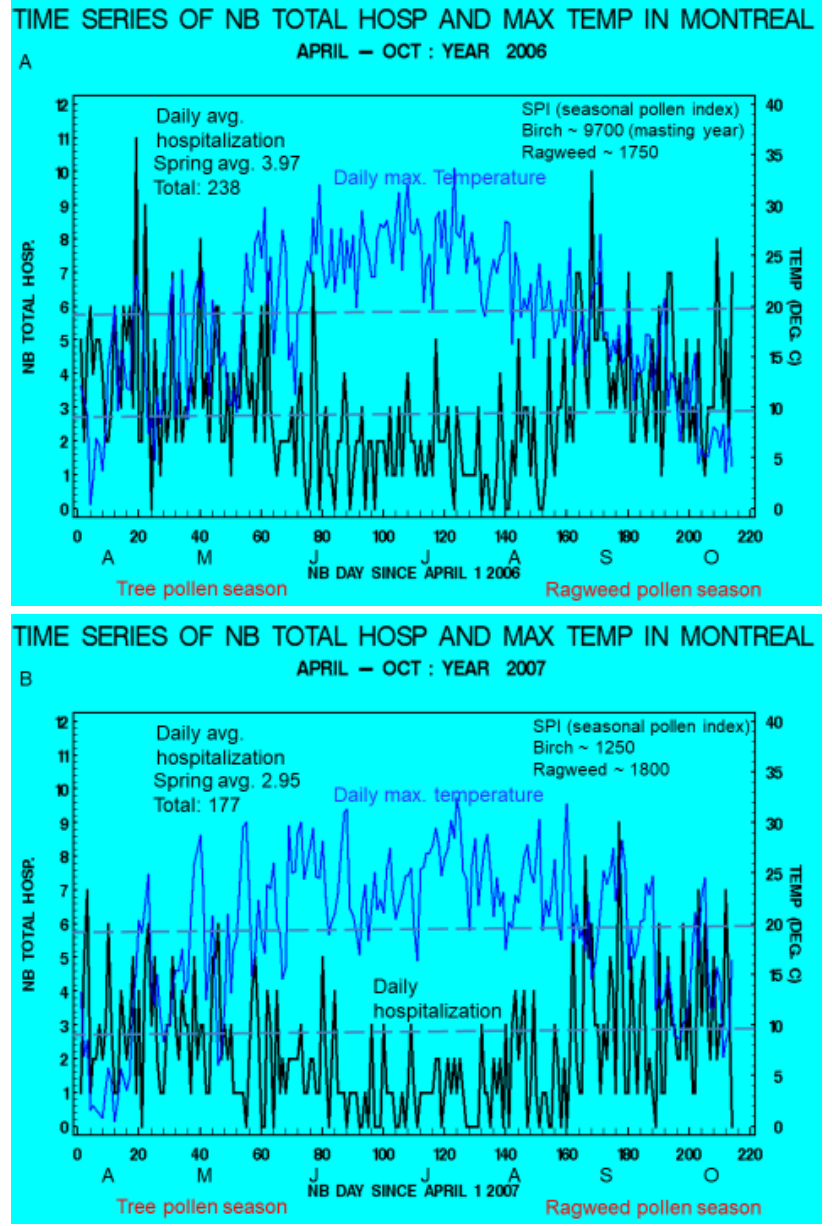
Figure 2. Time series of daily asthma hospitalization (DAH) count (in black) and daily maximum temperature (in blue) for the warm season of the year: ( A ) 2006 (SPI = 9700, total DAH = 238); ( B ) 2007 (SPI = 1250, total DAH = 177). The birch pollen season spans from April (A) through the first week of June (J) while the ragweed season takes place in September (S) and October (O) in Montreal. The two horizontal lines represent a window of temperatures between 10 and 20 °C where DAH is often peaking (see text for details).